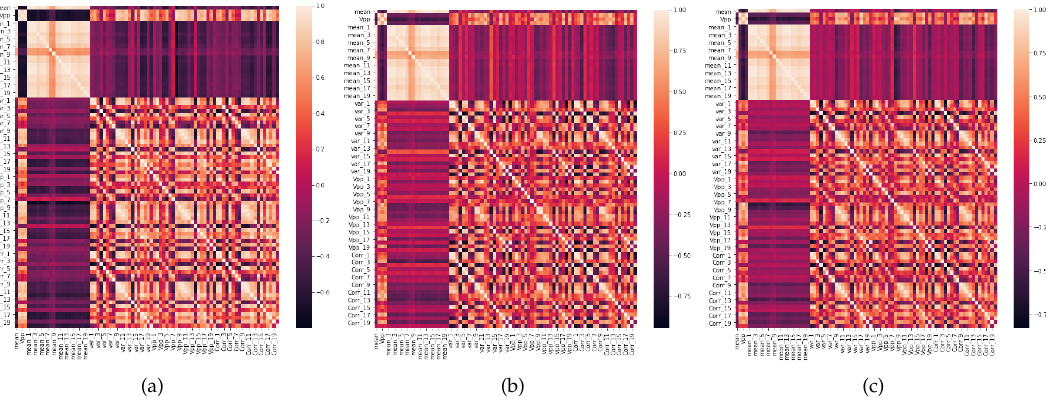
Figure 9. Correlation Heatmap: ( a ) Dataset 1, ( b ) Dataset 2, ( c ) Dataset 3. Table 4. Some important characteristics of the statistical